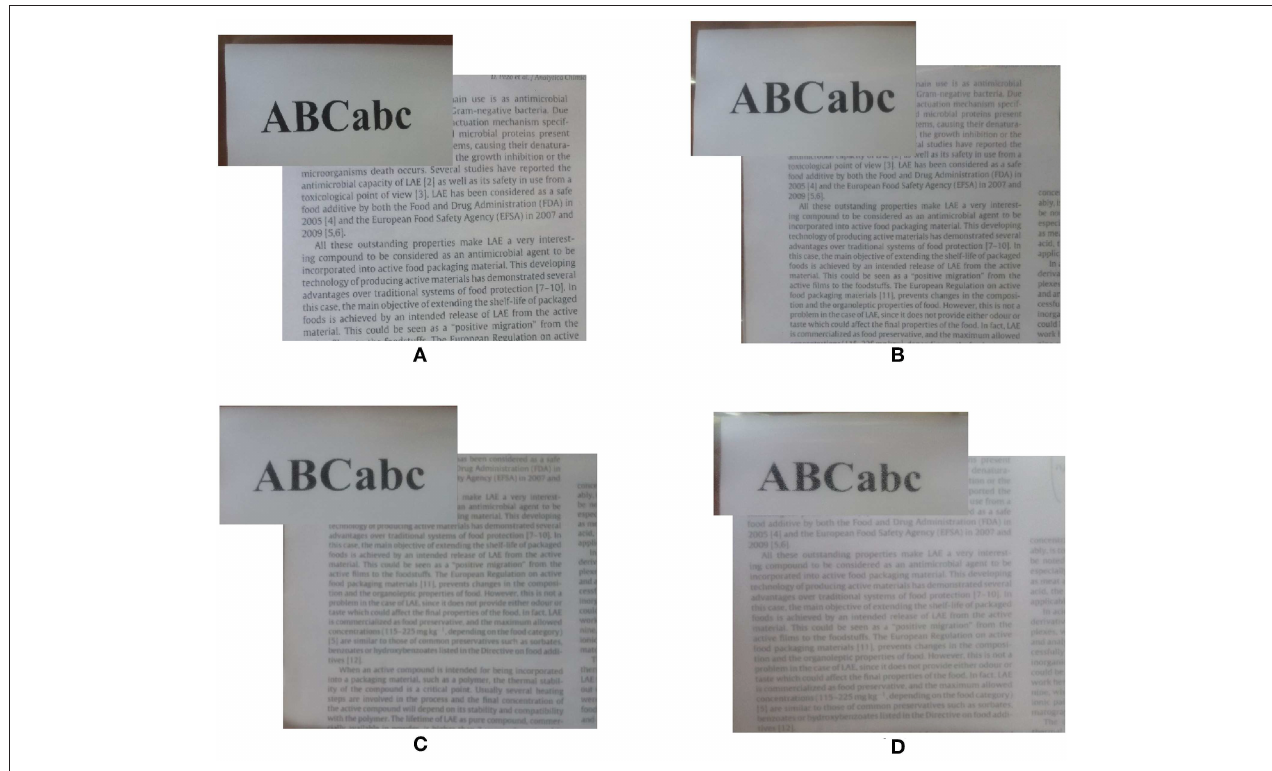
FIGURE 5 | Pictures of the SC coated films at different concentration of active agent: 0% LAE (A) , 5% LAE (B) , 10% LAE (C) , and 20% LAE (D)